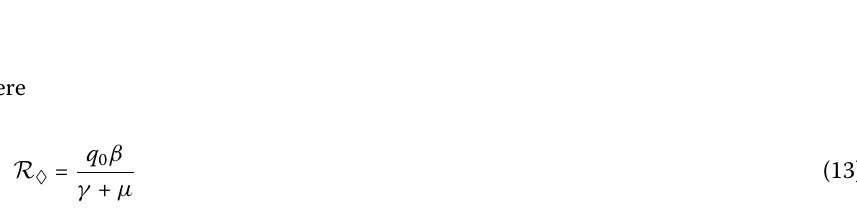
Figure 1 Time-dependent solutions for model (11) for R c = 0.9 and initial conditions x (0) = 0.6, y (0) = 0.3 and z (0) = 0.1. Model parameter values are as shown in Table